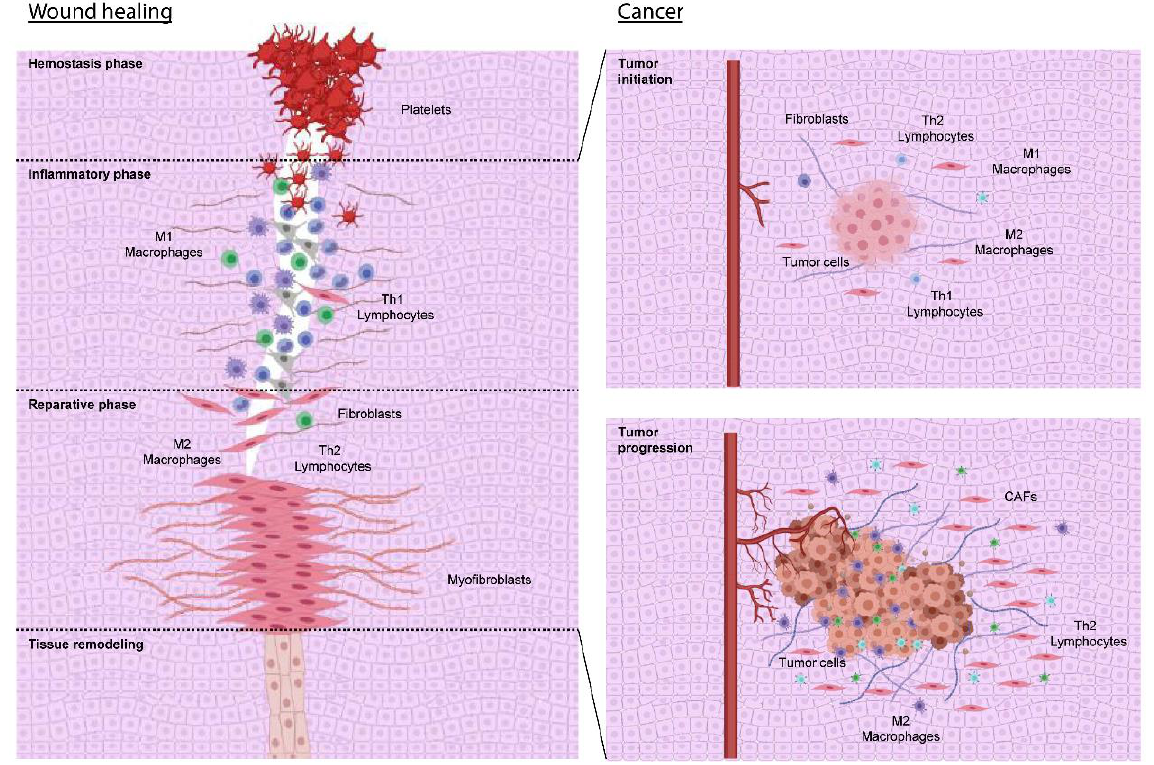
Figure 1. There is a parallel between wound healing and tumor growth. Wound healing consists of four consecutive phases (see text). A TH1 (T helper 1 cell)/M1 (M1-type macrophage) response predominates in the inflammatory phase, whose function is to eliminate necrotic debris and microor- ganisms. Once the tissue lesion is sterilized, the reparative phase begins. An anti-inflammatory and immunosuppressive TH2 (T helper 2 cells)/M2 (M2-type macrophage) activity predominates in this stage, favoring fibroblast activation and transformation into myofibroblasts. The metabolic changes of the lesion favor the change from TH1/M1 activity to TH2/M2 response. All this is very similar to what happens in tumors, where, in the initial stage, some inflammatory activity might be responsible for eliminating tumor cells that are sufficiently different from the antigenic point of view (immunoediting). A chronic regenerative phase then begins, in which TH2/M2 activity predominates and does not end because the tumor parenchyma does not stop sending signals to the surrounding stroma that allow tumor growth. Figure created using BioRender.